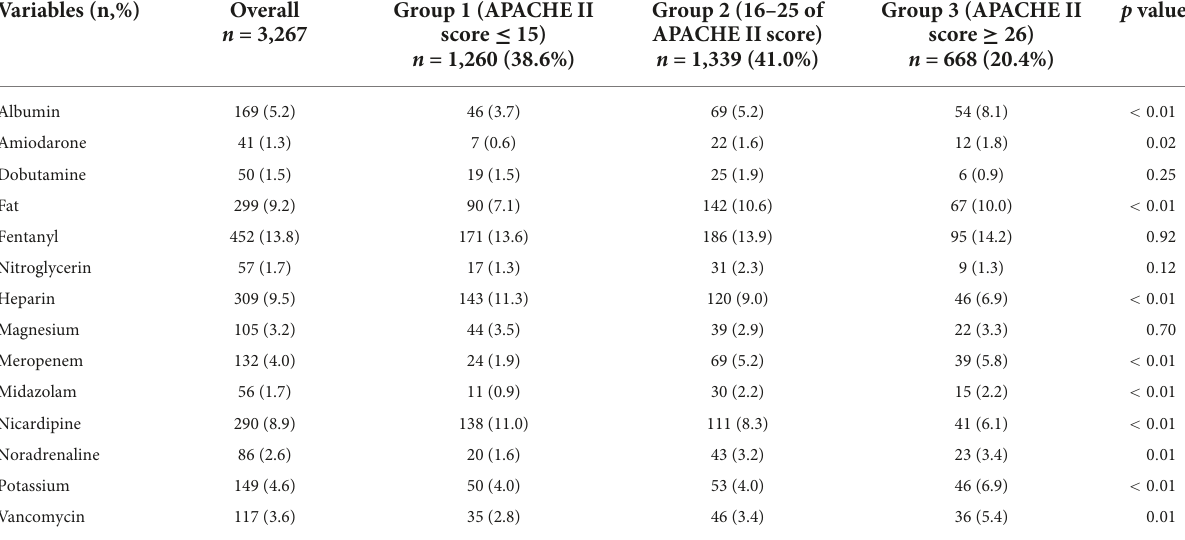
TABLE 3 Administered drug characteristics during insertion stratified using the APACHE II score*.